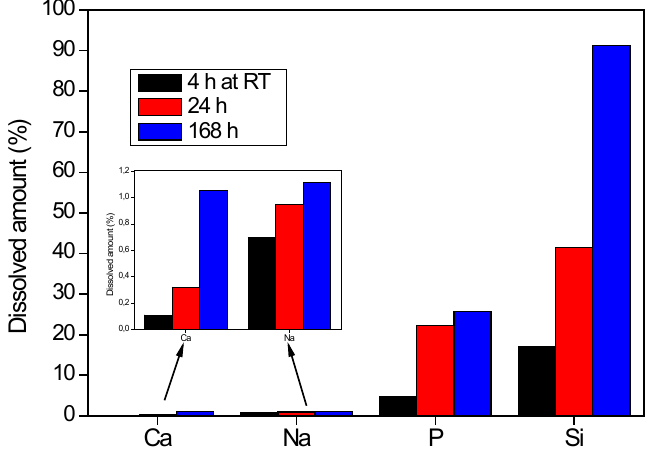
Figure 4. Effect of dissolution time Ca, Na, P and Si from RHA in alkaline medium.